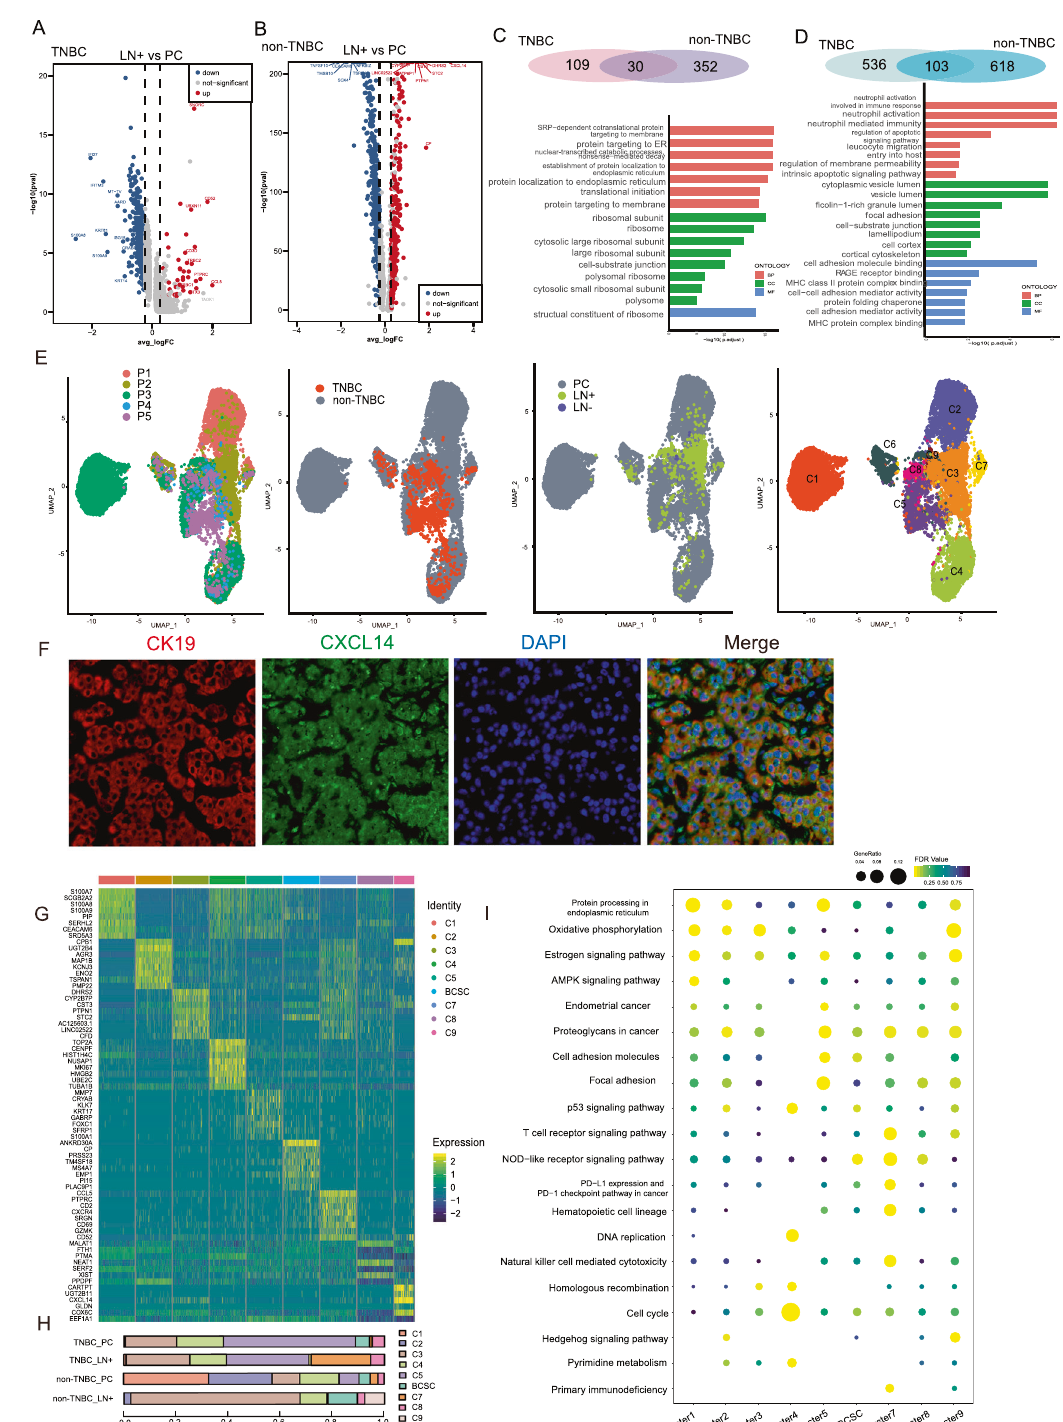
Fig. 3 Single-cell transcriptomics reveals distinct cancer cell subpopulations. A , B Volcano plots of TNBC ( A ) and non-TNBC ( B ) showing differentiated expressed genes of cancer cells derived from lymph node metastasis against cancer cells from primary tumors. C Venn plots showing the relationship of upregulated genes in lymph node metastasis of TNBC and non-TNBC. D Venn plots showing the relationship of downregulated genes in lymph node metastasis of TNBC and non-TNBC. E UMAP plots of cancer cells derived from 15 paired samples of primary tumors and axillary lymph nodes, colored according to patients, molecular subtypes, sample origins, and cancer cell clusters. F Immuno fl uorescence staining showing the differentiated expression of CXCL14 in cancer cells derived from lymph node metastasis. G Heatmap showing differentiated expressed genes of nine cancer cell clusters. H Cancer cell composition of samples according to molecular subtypes and tumor origins. I Gene ontology (GO) enrichment of nine cancer cell